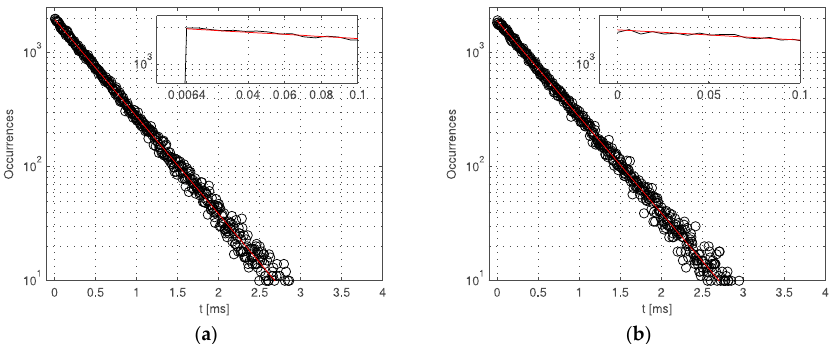
Figure 8. Pixel characterization: ( a ) PDP vs. wavelength at given excess bias voltages; ( b ) DCR distribution at 40 °C for V e = 4.5 V, with an average of 1169 cps and a median of 302 cps. In the inset the DCR distribution is shown.